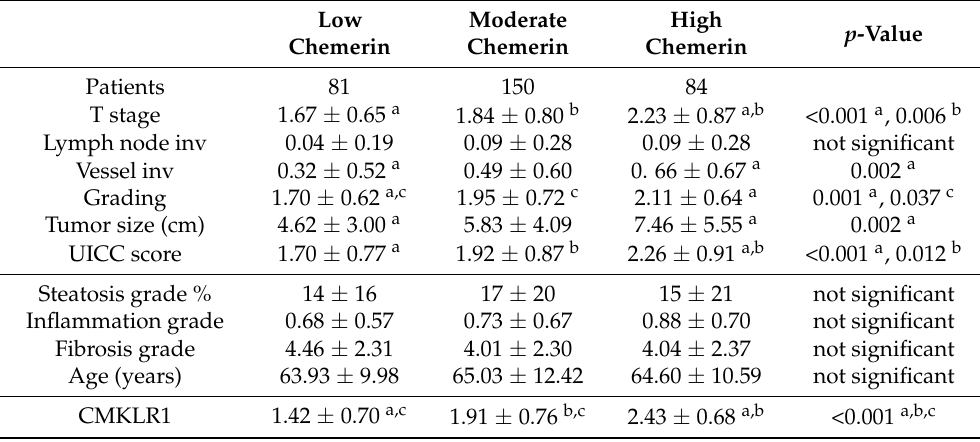
Table 3. T stage, lymph node invasion, vessel invasion, grading, UICC stage, steatosis, inflammation, fibrosis stages, age, and CMKLR1 scores of male patients stratified for low, moderate, and high chemerin protein levels in the tumors. a: comparison of tumors with low and high chemerin, b: comparison of tumors with moderate and high chemerin, and c: comparison of tumors with low and moderate chemerin (inv,